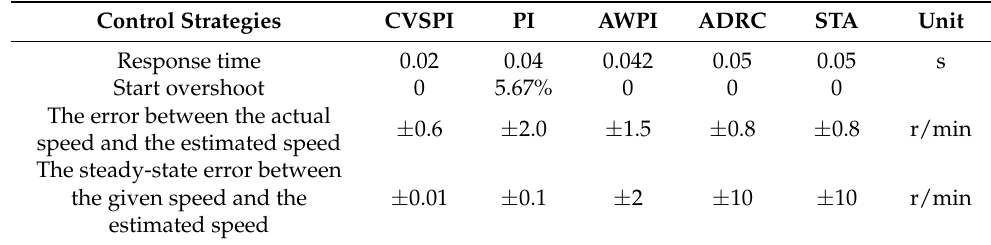
Table 3. Performance comparison with a peak of 580 r/min and a trough of 520 r/min at 15 hz.